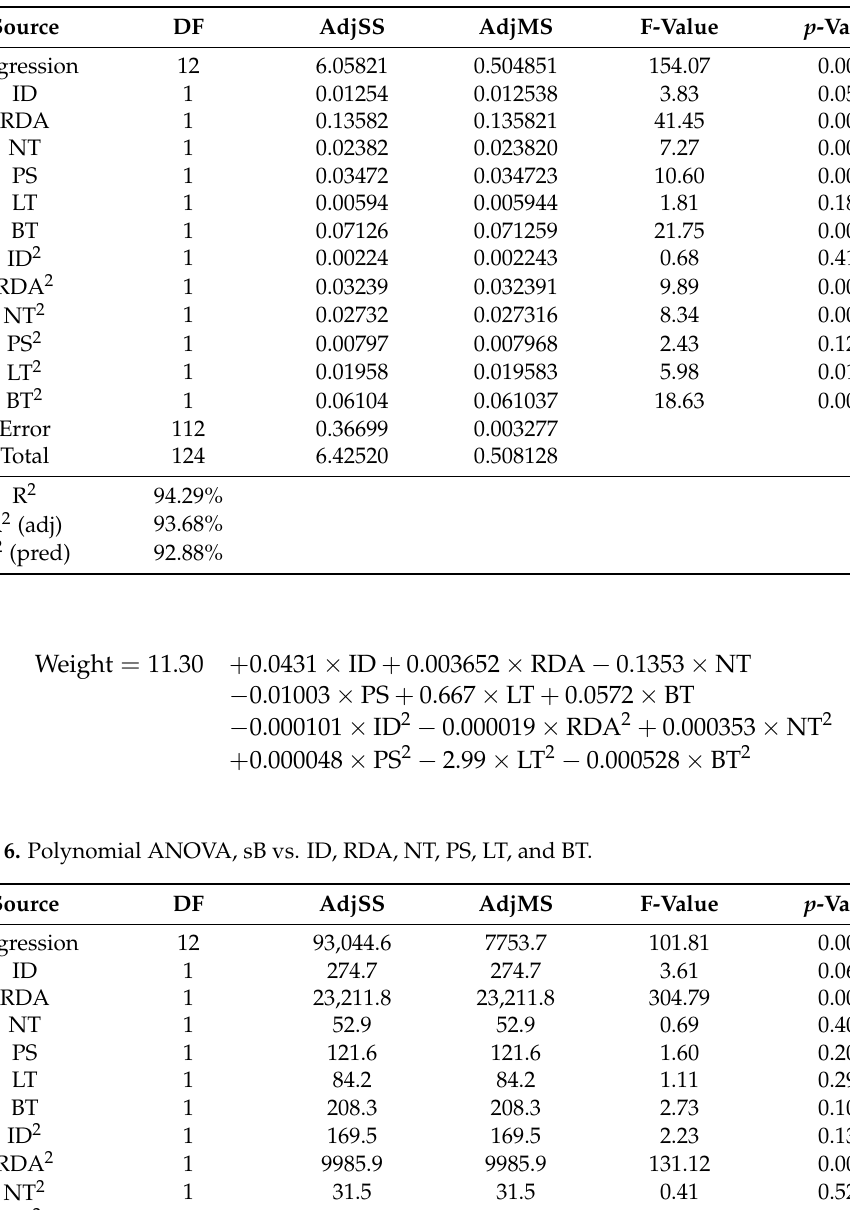
Table 5. Polynomial ANOVA, weight vs. ID, RDA, NT, PS, LT, and BT. Source